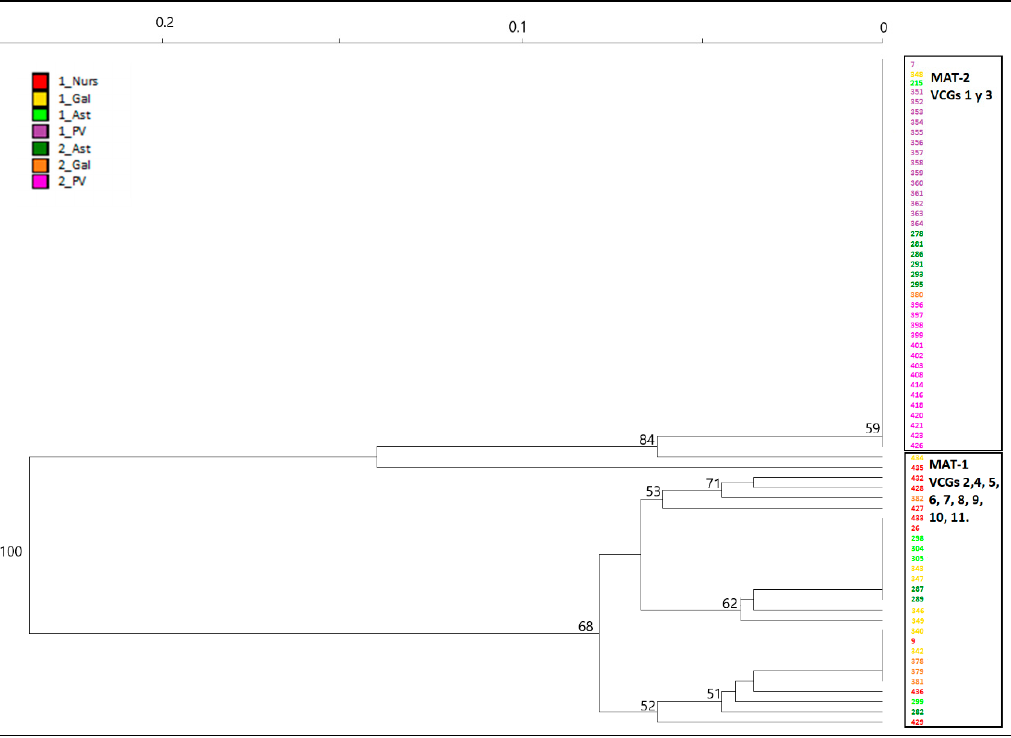
Figure 3. NJ dendrogram of Spanish Fusarium circinatum isolates based on six polymorphic SSR markers generated with Bruvo’s genetic distance [48]. VCGs (1 to 11) and Mating types (MAT ‐ 1 and MAT ‐ 2) are shown on the right side. Bootstrap values based on 1000 repetitions, shown when values >50%. Isolates collected from surveys (1_) in 2004–2011 and (2_) in 2018–2021, from Galicia (Gal), Asturias (Ast), País Vasco (PV), and nurseries (Nurs).